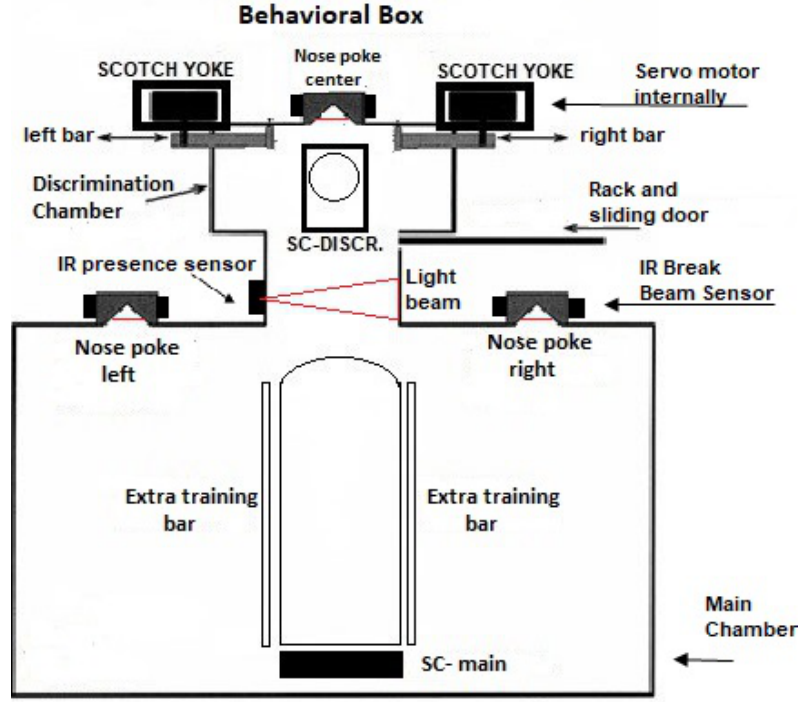
Figure 1. Schematic design of the behavioral box.